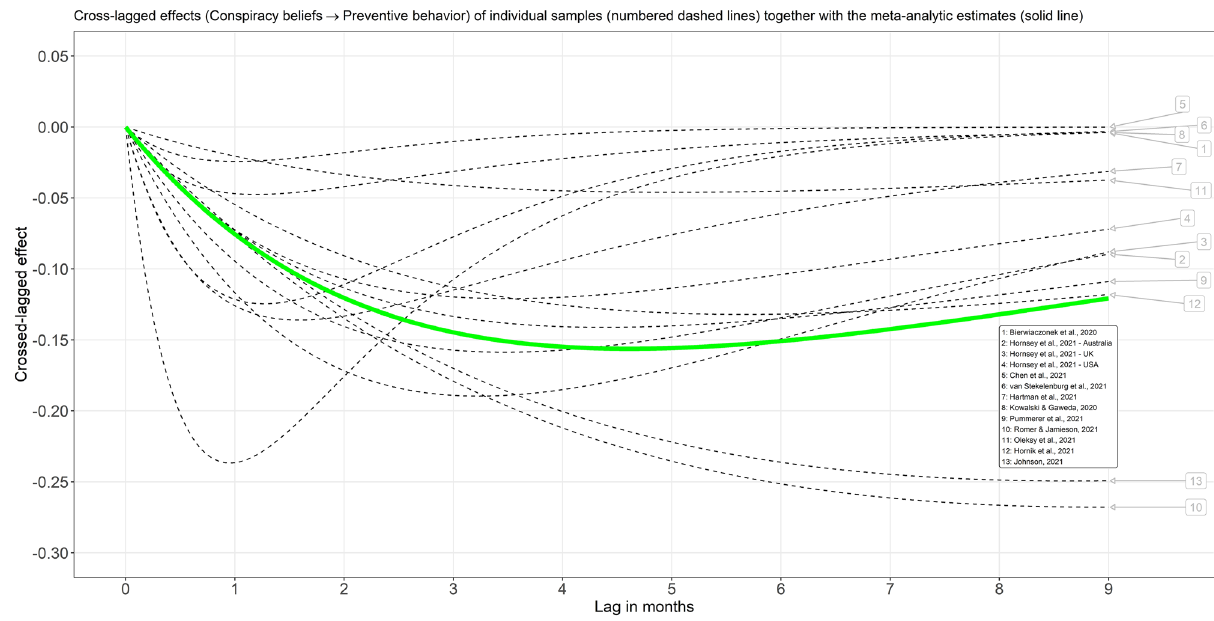
Figure 2. Model-implied cross-lagged effects (conspiracy beliefs → preventive behavior) for a range of time lags in months. On average, data for approximately 3 to 4 months were available. Thus, parts of the individual trajectories are simple extrapolations. For short studies, such as 1 and 8, the cross effects at large time lags cannot be reliably estimated. Hence, the largest effects in short studies are shifted to shorter time lags than the meta-analytic